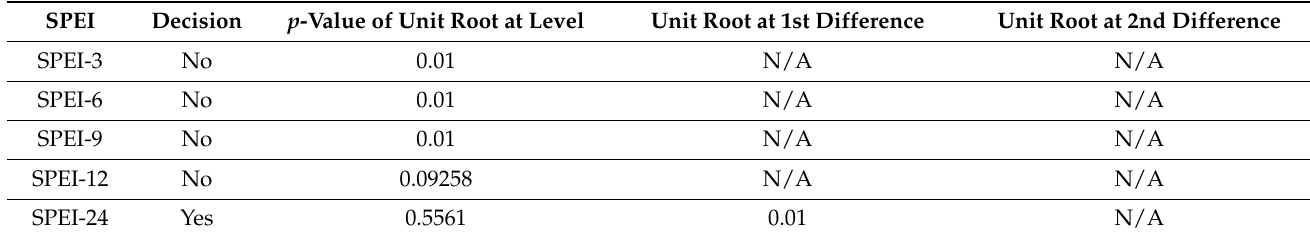
Table 4. Phillips–Perron unit root test.